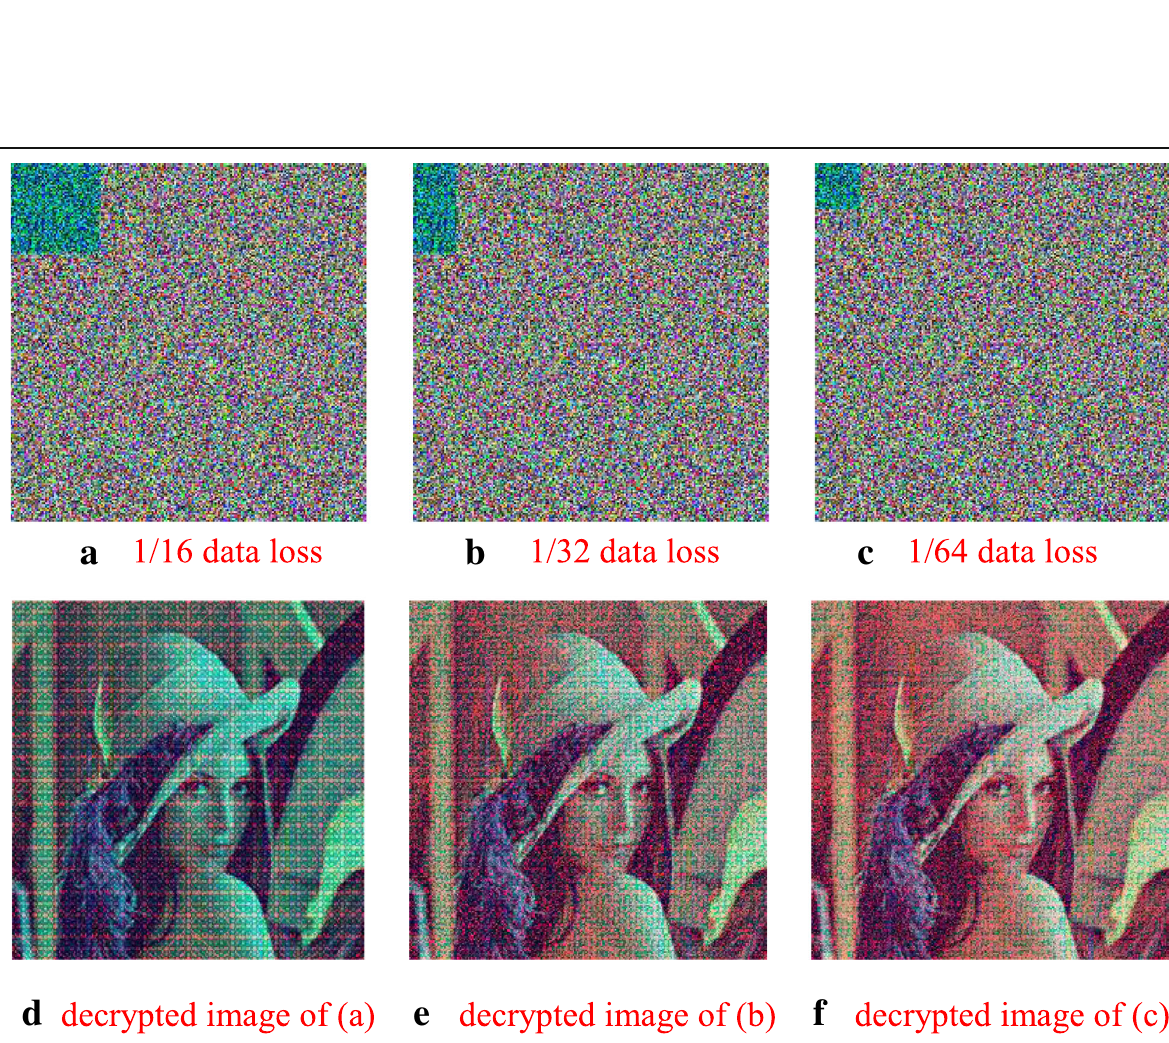
Fig. 8 Cropping attack analysis results. a 1/16 data loss; b 1/32 data loss; c 1/64 data loss; d decrypted image of ( a ); e decrypted image of ( b ); f decrypted image of ( c